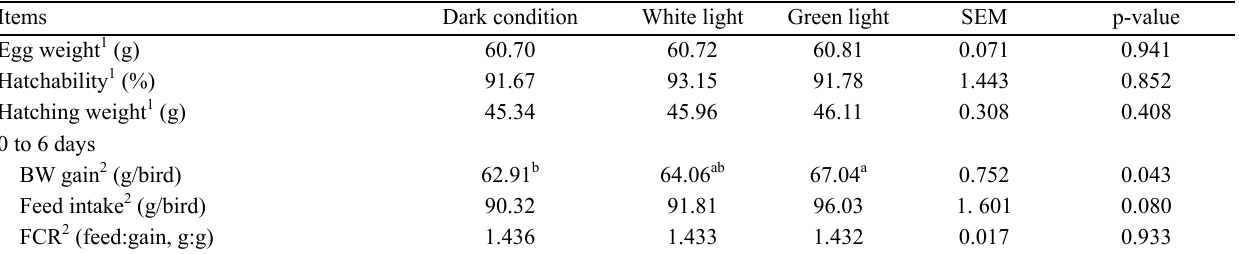
Table 1. Effects of light-emitting diodes-based light stimuli during incubation on hatching weight, hatchability and chick growth performance from o to 6 days posthatch